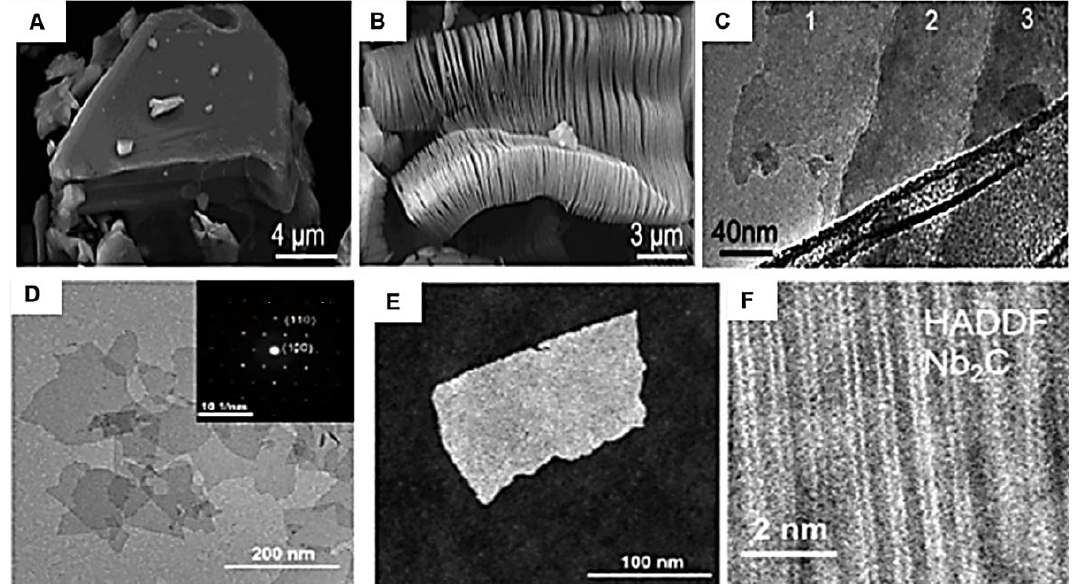
Figure 4. ( A ) SEM micrographs of Ti 3 AlC 2 before and ( B ) after etching. ( C ) TEM images of Ti 3 C 2 after etching [1] © American Chemical Society (2012). ( D , E ) TEM images (bright and dark field Nb 2 C).